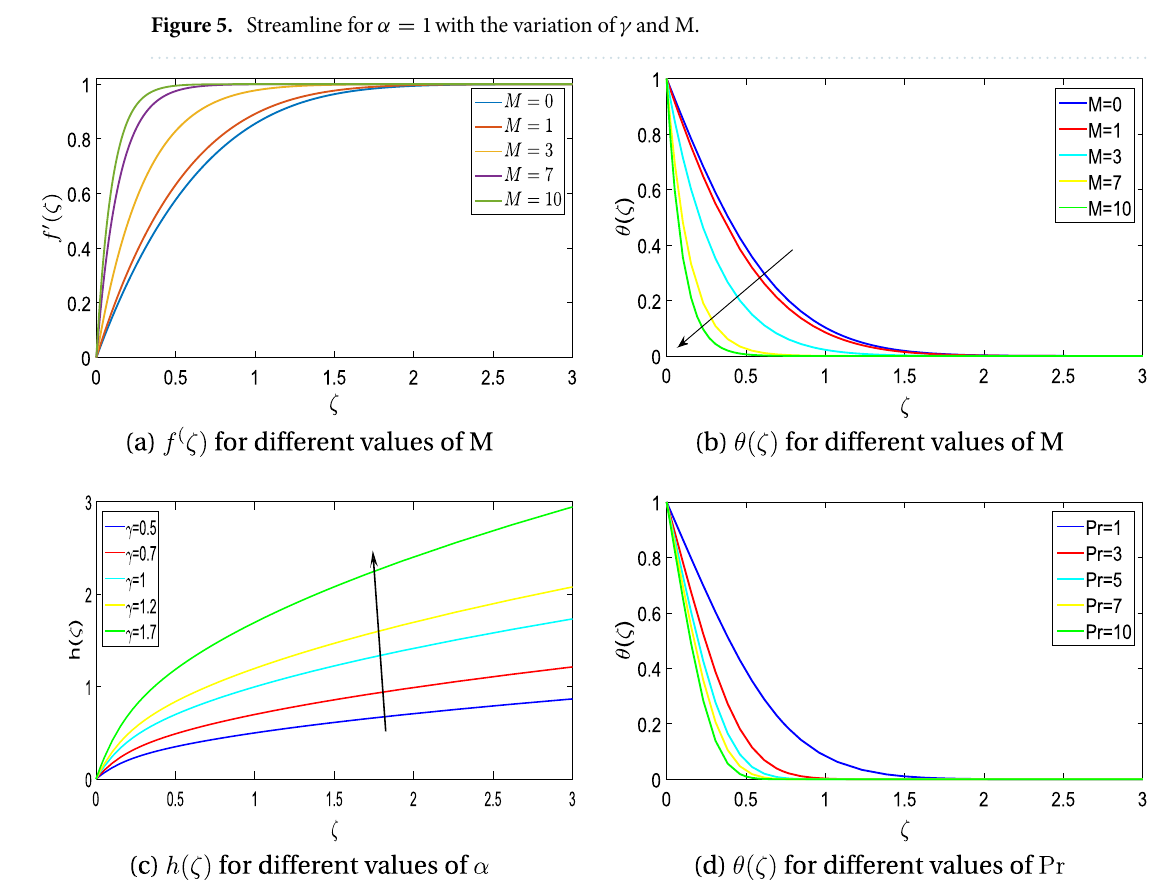
Figure 6. Velocity and temperature profiles for magnetic parameter M , rotation ratio α and obliqueness γ